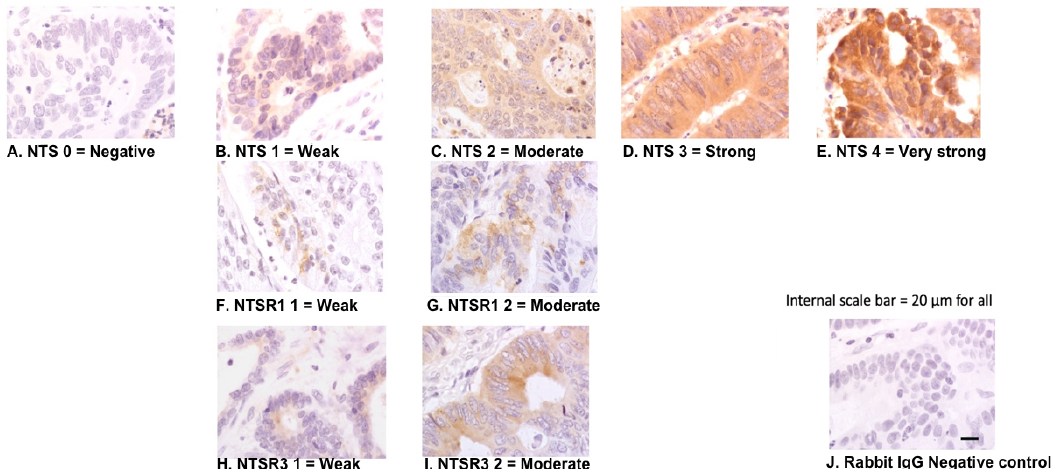
Figure 1. Peroxidase immunohistochemical staining for NTS: ( A ) negative, ( B ) weak signal, ( C ) moderate signal, ( D ) strong signal, ( E ) very strong signal. NTSR1: ( F ) weak signal, ( G ) moderate signal. NTSR3: ( H ) weak signal, ( I ) moderate signal. Rabbit IgG negative control ( J ). Internal scale bar = 20 µm for all.